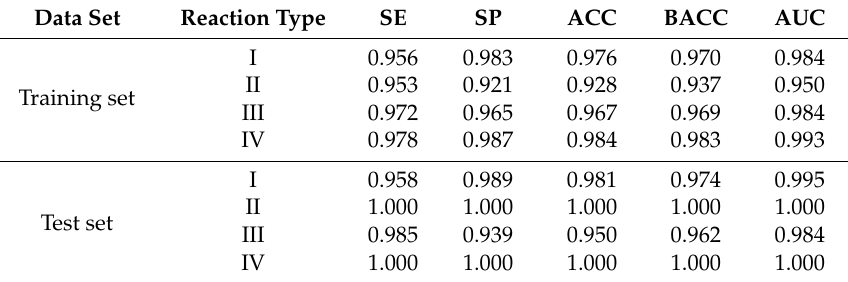
Table 2. Prediction quality of the four optimal models, in terms of different statistic indices. Data